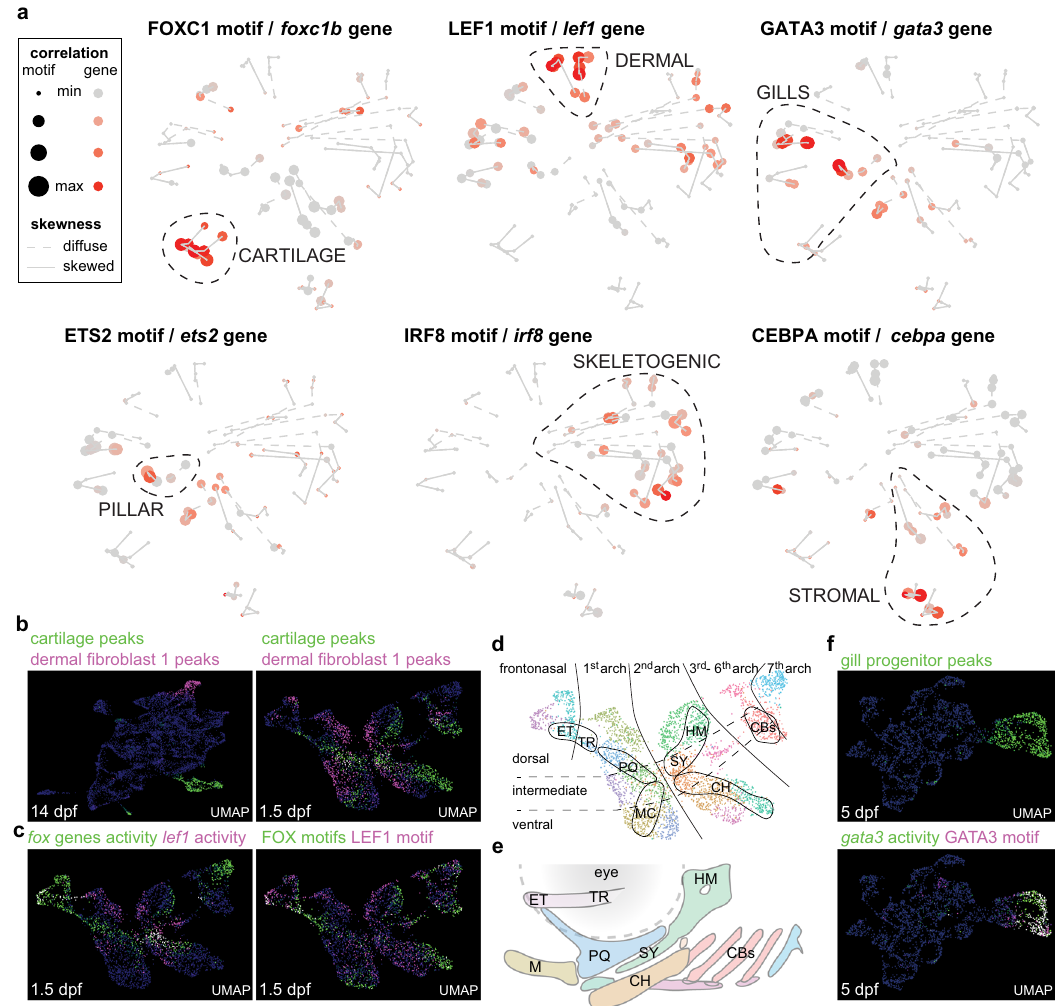
Fig. 5 Constellations analysis reveals candidate transcription factors for lineage priming. a Mapping onto the Constellations plot of transcription factors with correlated gene body activity and DNA-binding motif enrichment in speci fi c clusters. Sizes of circles denote correlation of peak module mapping to motifs, and red color to gene body activities. b Top peak modules for hyaline cartilage and dermal fi broblast 1 clusters at 14 dpf mapped onto 14 dpf